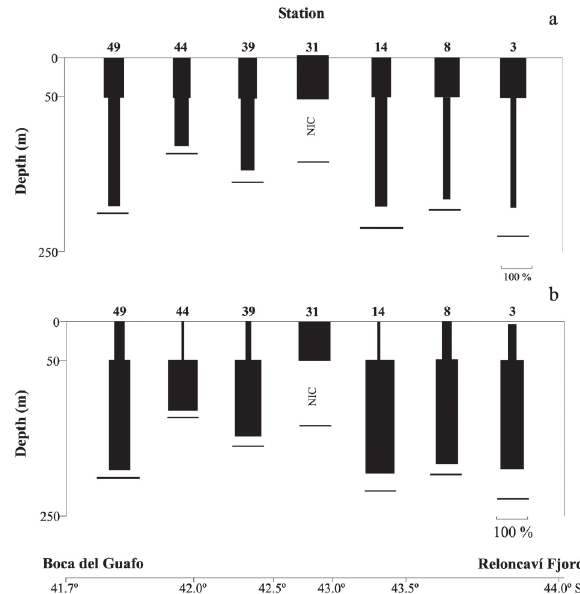
Fig . 6. – Vertical distribution of Sagitta tasmanica . a) Individuals without eggs, b) individuals with eggs. Black bars indicate the depth of the marine floor at the sampling stations. NIC: no individuals were